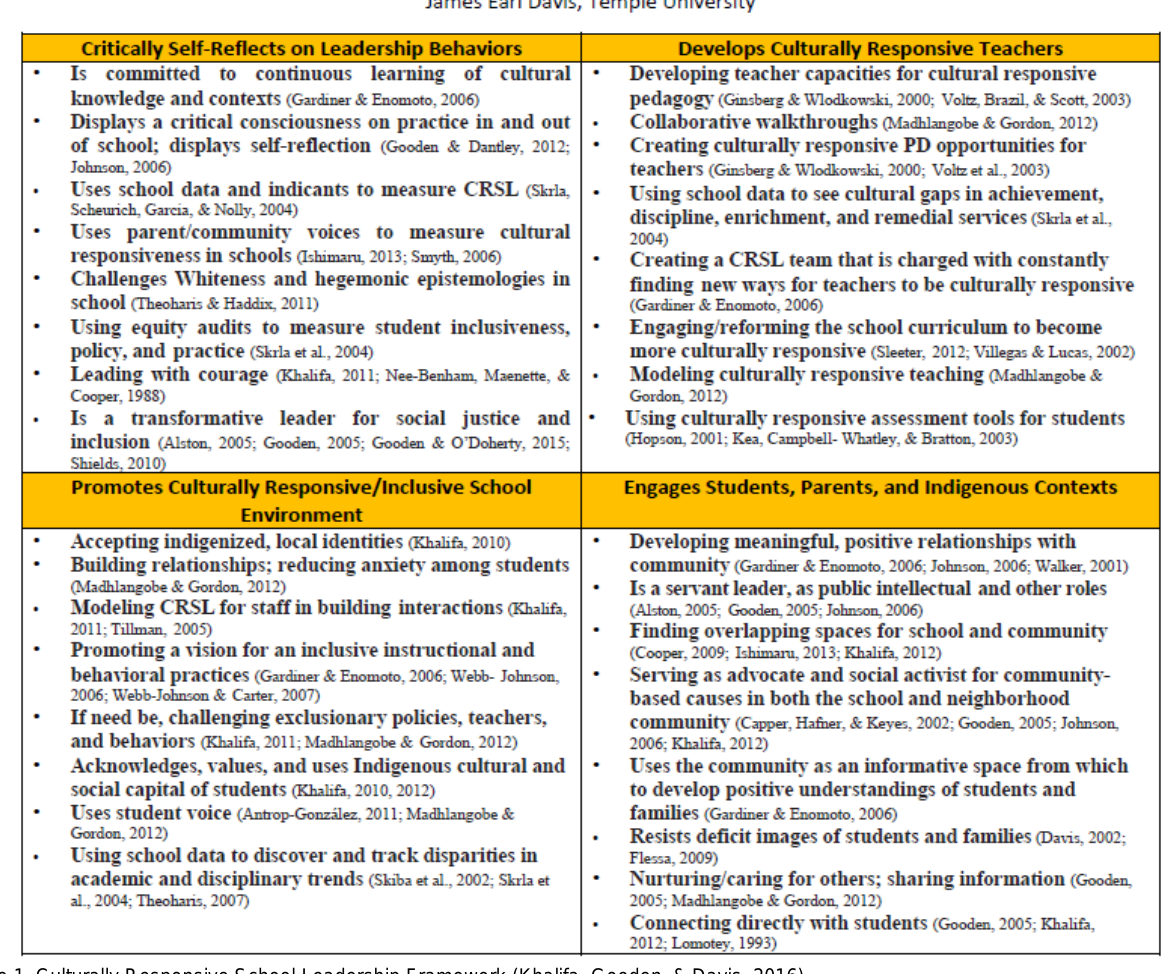
Table 1. Culturally Responsive School Leadership Framework (Khalifa, Gooden, & Davis,